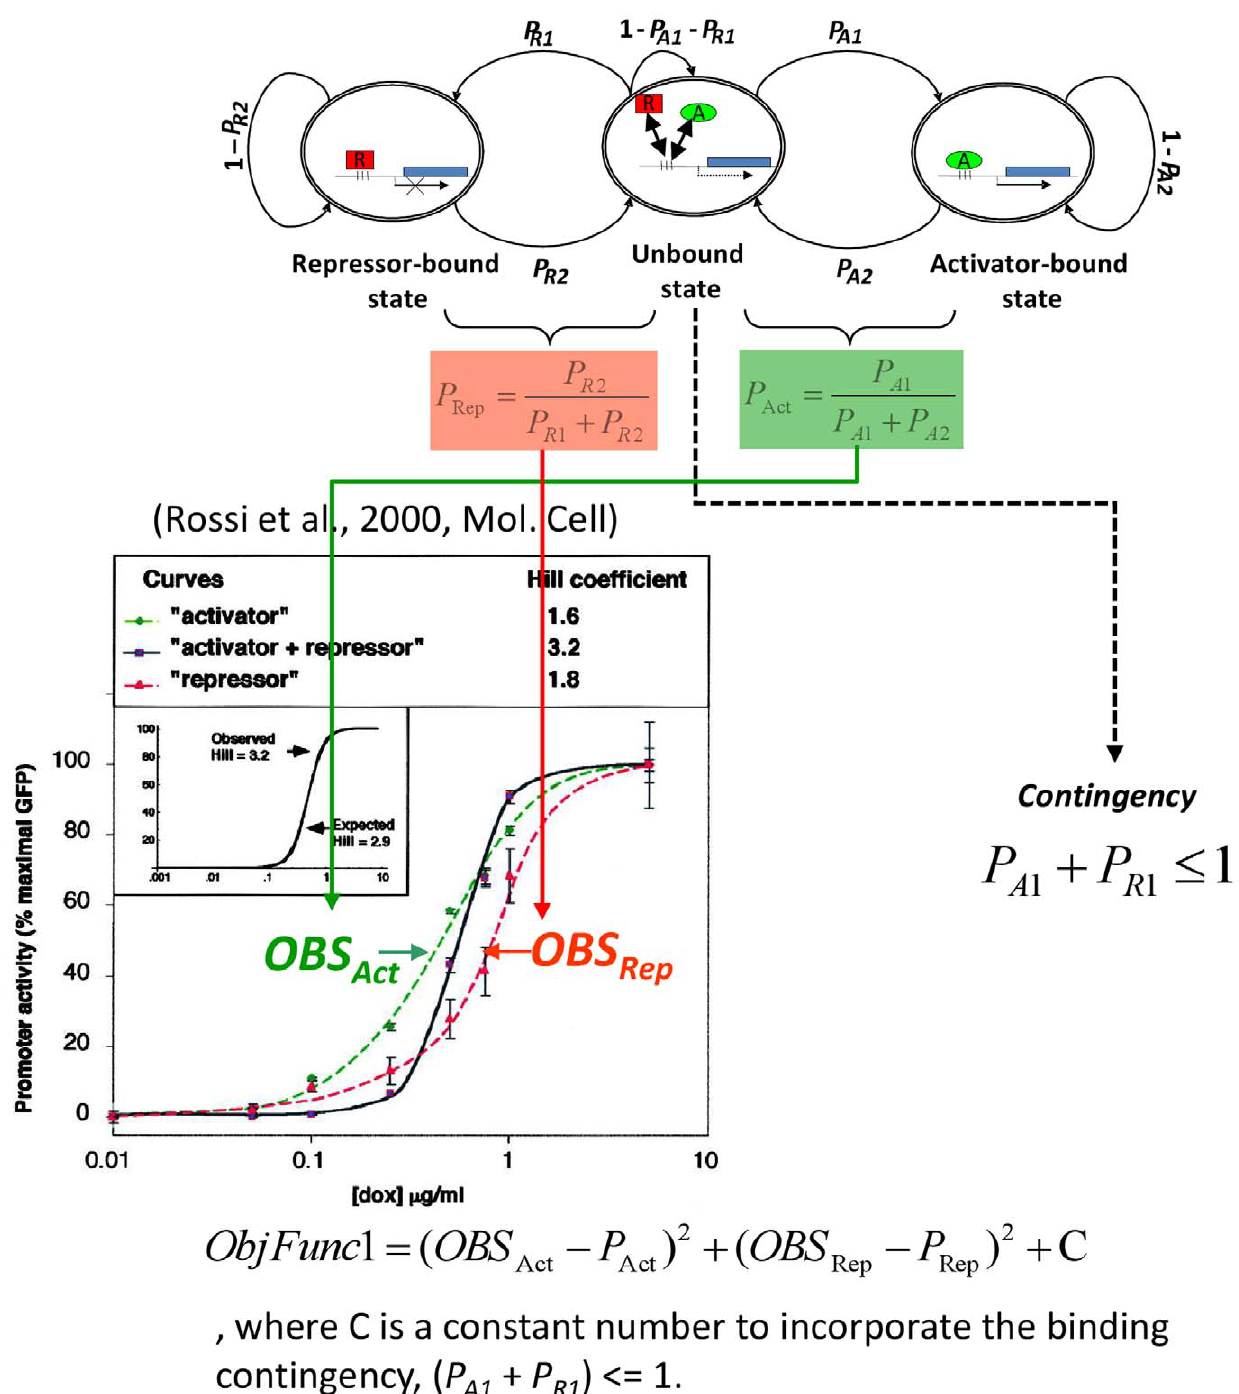
Figure 2. A strategy of parameter estimation for a 3-state MCM. All the parameters for the 3-state MCM were estimated from the published data only on the dose-response experiments of activator only and repressor only [20]. In the case of activator only, parameters in P Act (Eq. 3 or Eq. 10 ) were estimated by using the observed dose-response curve ( OBS Act : a Hill function of [dox]) represented by the equation (Eq. 4 or Eq. 11 ) in the Materials and Methods section. The repressor only case ( OBS Rep , P Rep ) was handled in the same manner.